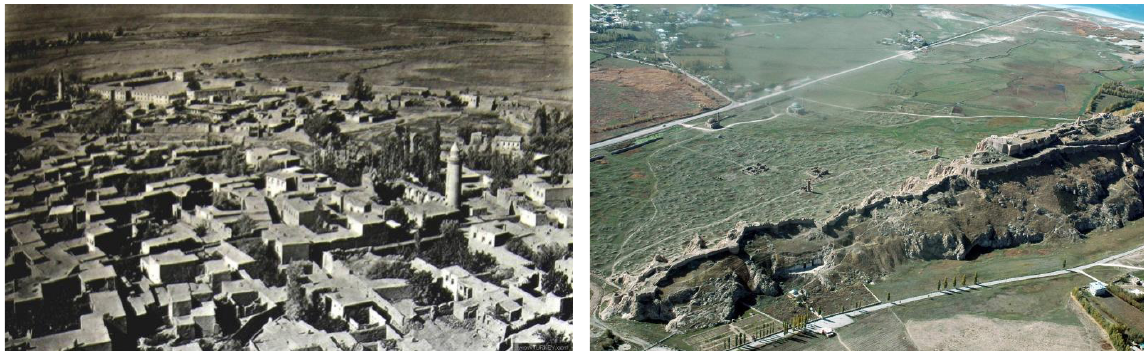
Figure 3 Historic monuments in the Old Town of Van (redrawn form Saban Ökesli and Akar, 2012, p. 36)